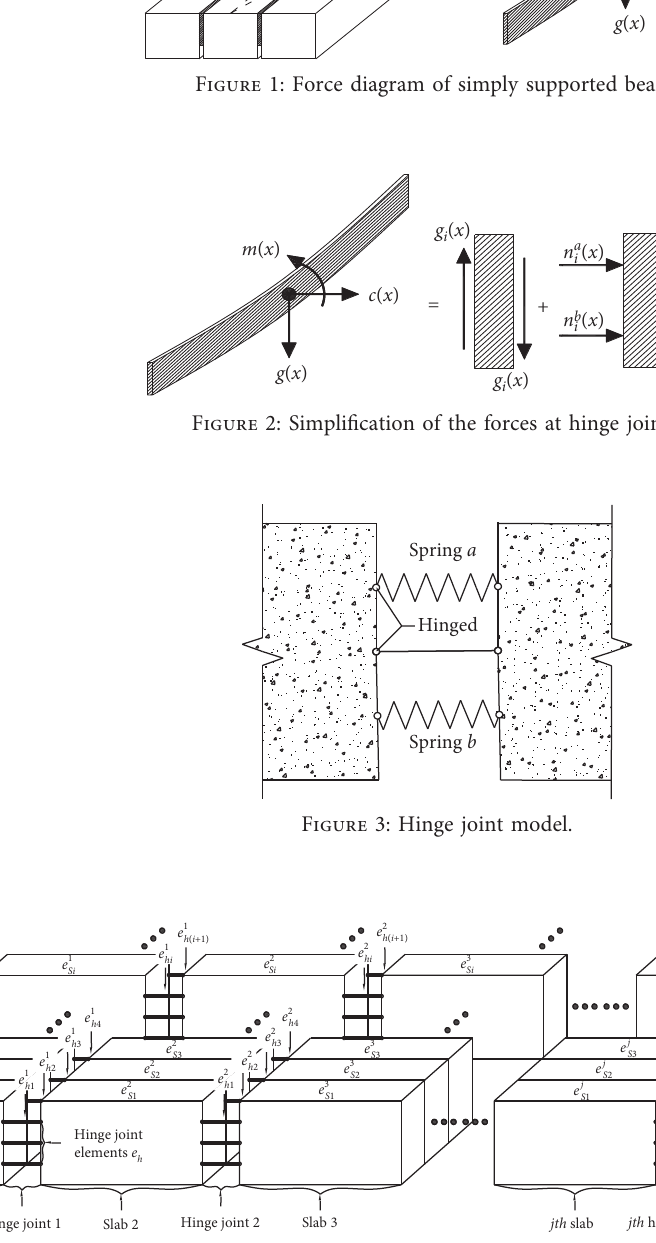
Figure 4: Structure segmentation and unit